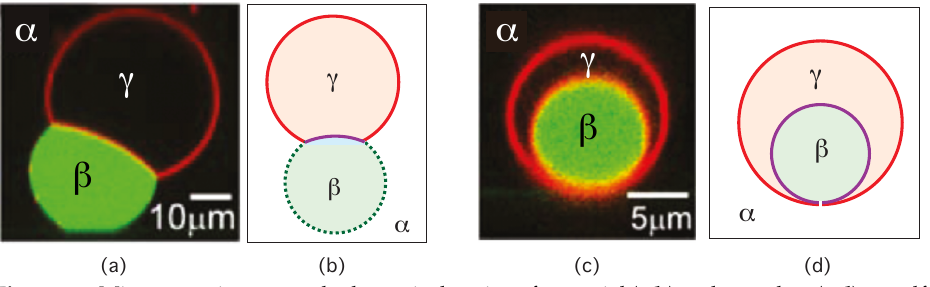
Figure 22. Microscopy images and schematic drawings for partial ( a , b ) and complete ( c , d ) engulfment of a condensate droplet β (green) by the membrane (red) of a giant vesicle [11]. For complete engulfment, the membrane forms two spherical segments that are connected by a narrow or closed membrane neck. This neck is not resolvable by conventional confocal microscopy but is indicated in the schematic drawing in ( d ). The color code in the drawings is the same as in Figure